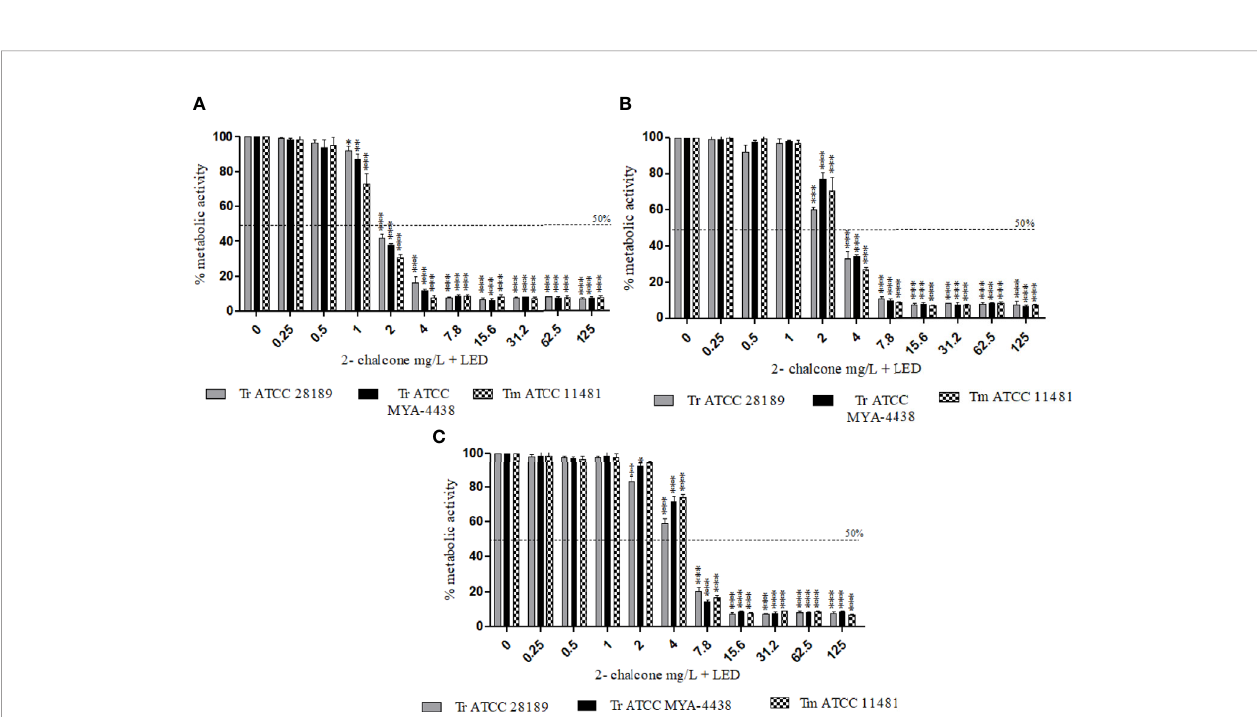
FIGURE 4 | Effect of 2-chalcone-mediated PDT using LED irradiation at a dose of 150 J/cm 2 in planktonic cells (10 6 cell/mL) (A) , early-stage (B) , and mature bio fi lms (C) of T. rubrum ATCC 28189, T. mentagrophytes ATCC 11481, and T. rubrum ATCC MYA-4438, measured by the XTT reduction assay. Potentiation of 2-chalcone was shown when it was mediated PDT resulting in the inhibition of planktonic forms and bio fi lms (early-stage and mature) from 2, 4, and 7.8 mg/L. (*p < 0.05; **p < 0.01; ***p < 0.001).